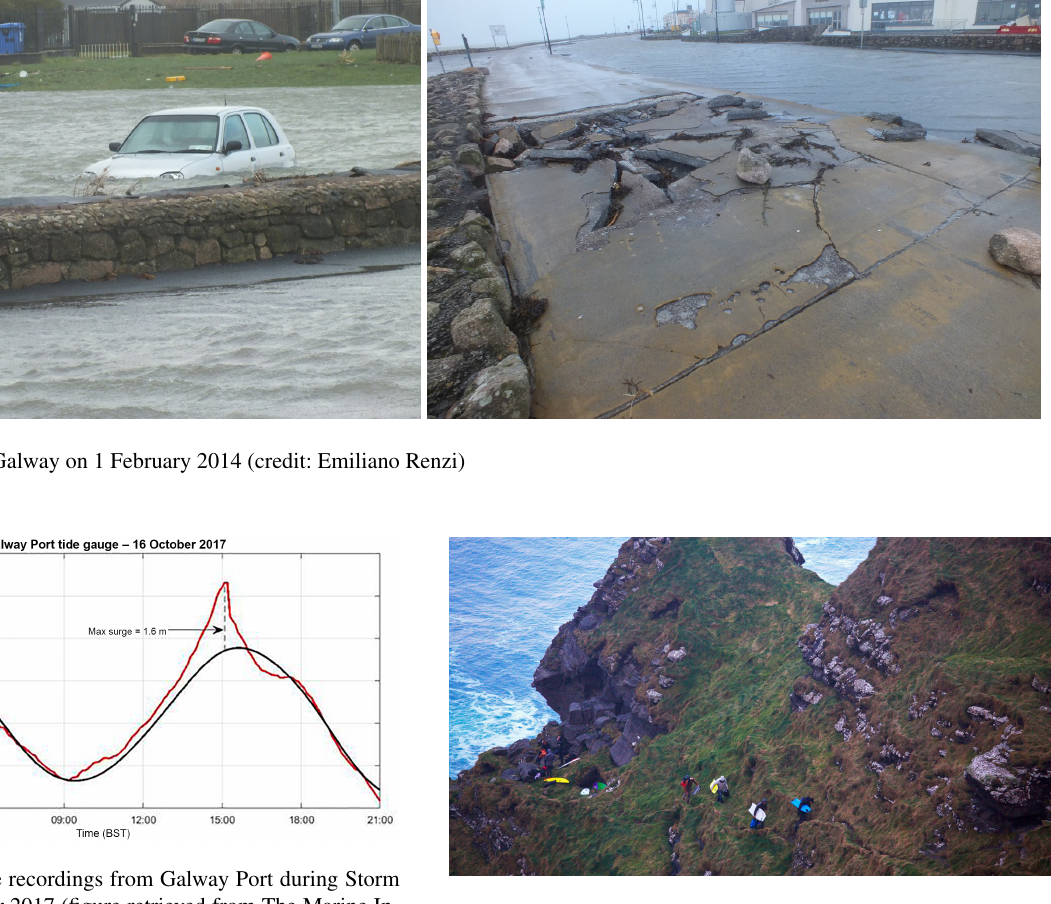
Figure 20. Surfers hike back up a cliff after surfing Aileen’s wave, Co. Clare (Craig,